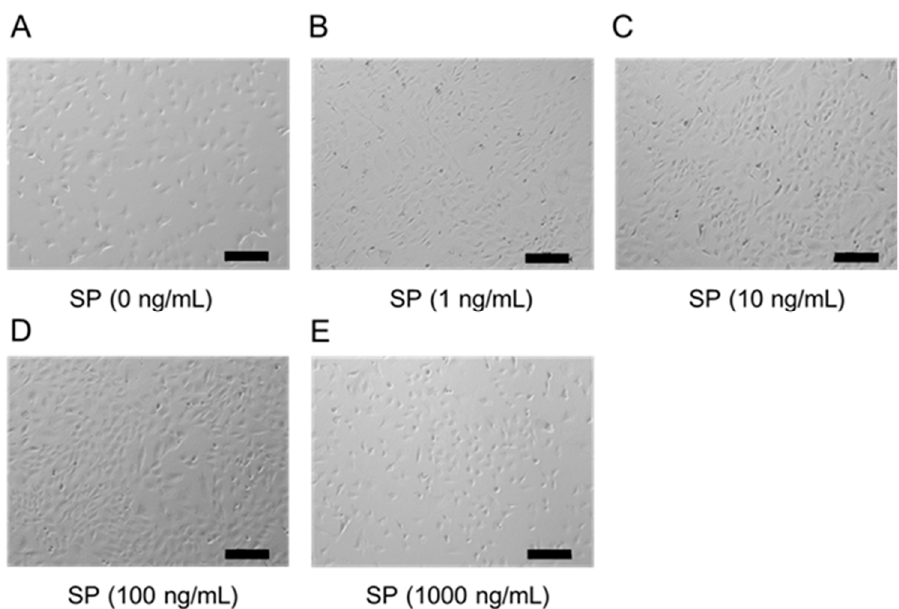
Figure 2. Effect of SP on cell morphology in KN-3 cells. Cell morphology in KN-3 cells treated with SP. Cells were cultured with SP (0 to 1000 ng/mL) for 48 h. Scale bar indicates 200 µ m. ( A ) SP (0 ng/mL), ( B ) SP (1 ng/mL), ( C ) SP (10 ng/mL), ( D ) SP (100 ng/mL), ( E ) SP (1000